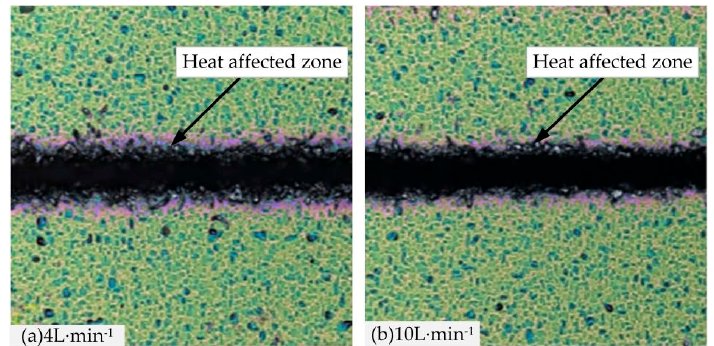
Figure 9. Heat-affected zone of cutting surface with different water velocities. Reprinted from [39], with permission from Trans Tech Publications. with permission from Trans Tech